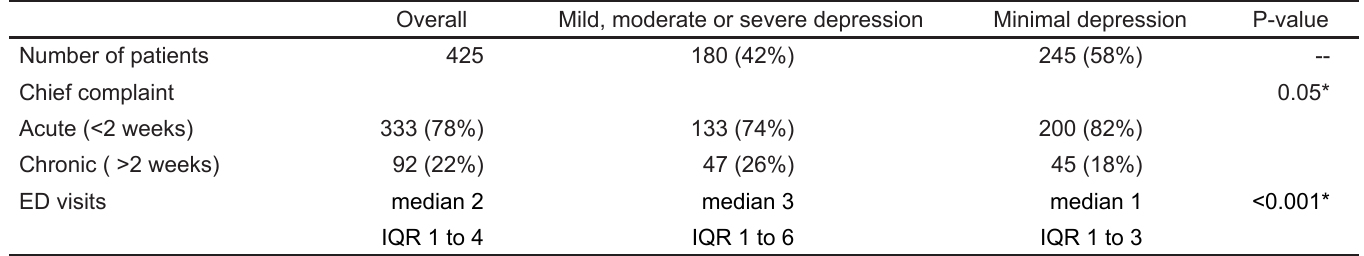
Table 3. Chief complaints and number of emergency department (ED) visits by severity of